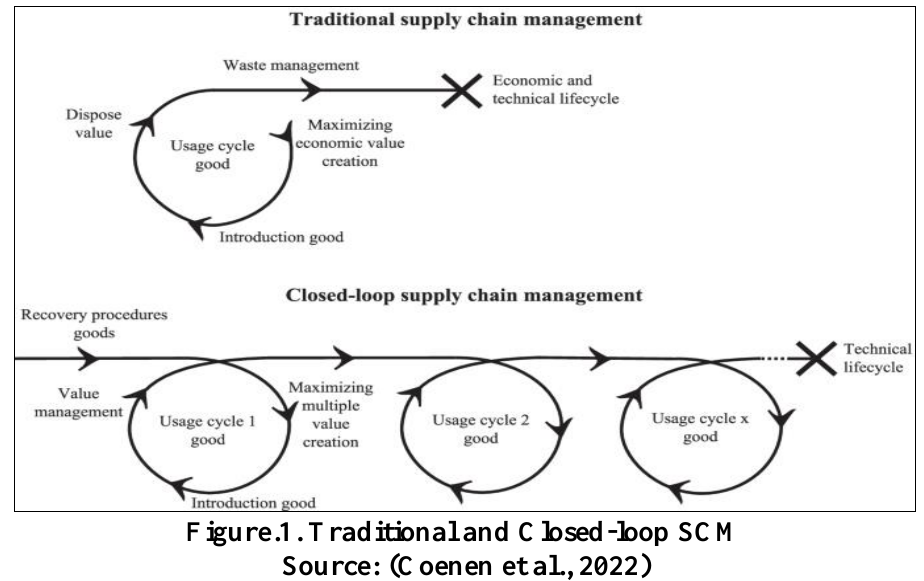
Figure.1. Traditional and Closed-loop SCM Source: (Coenen et al., 2022)